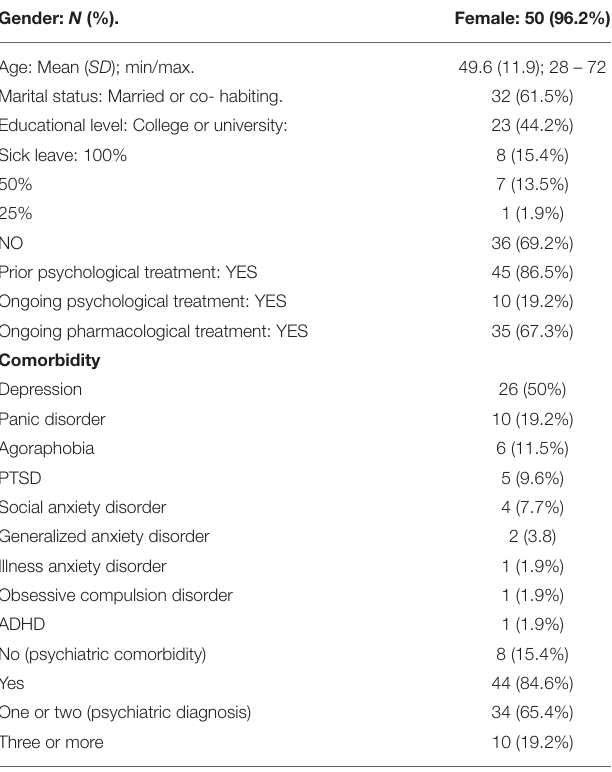
TABLE 4 | Feasibility outcomes.